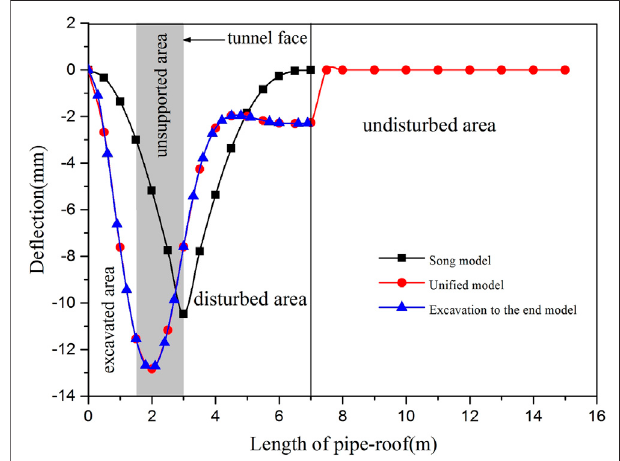
FIGURE 7 | The de fl ection of the steel pipe in the pipe-roof.